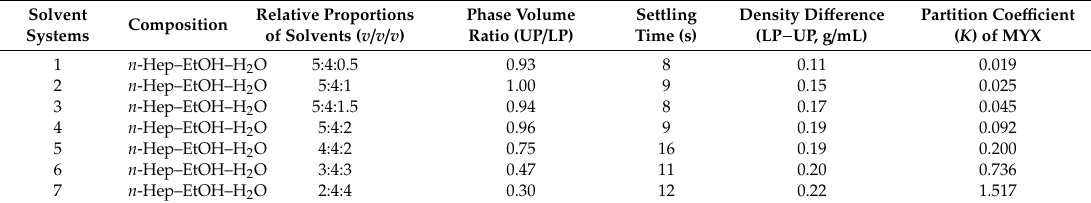
Table 1. The partition coe ffi cient ( K ) of myxoxanthophyll in di ff erent biphasic solvent systems, density di ff erences and the settling